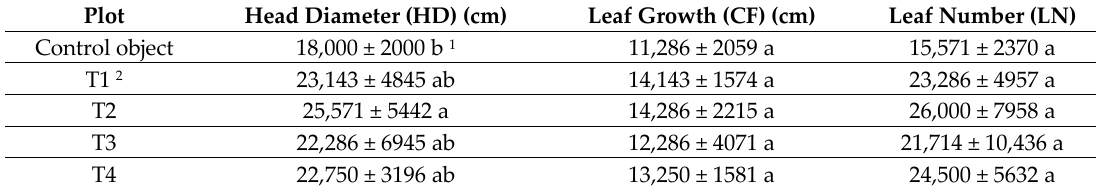
Table 2. Average values and standard deviation for HD, CF and